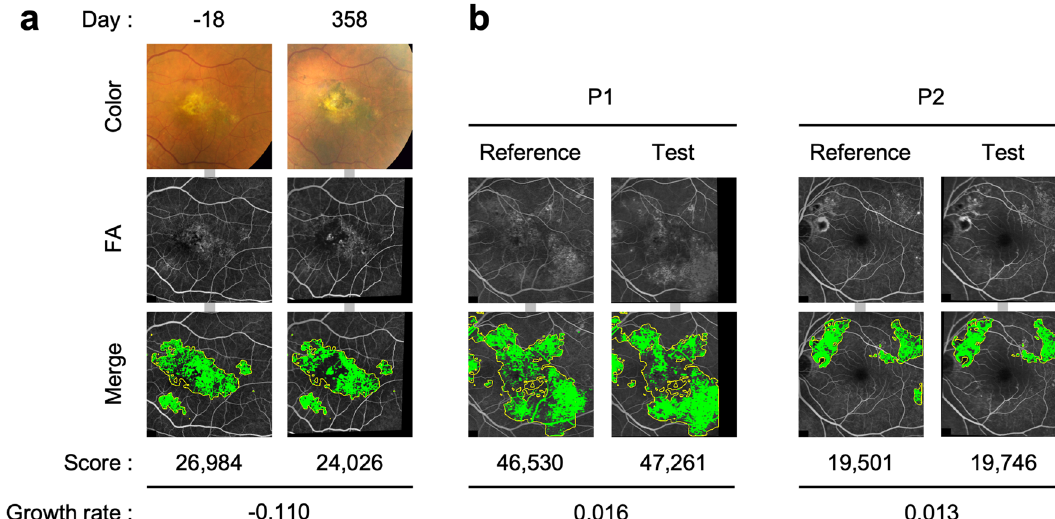
Figure 7. Application of the program to iPSC-RPE cell transplantation and CSC images. ( a ) Quantitative assessment of the Hyperfluorescent areas before and after human iPSC-RPE transplantation in a previously reported case 8 . The date of iPSC-RPE transplantation surgery was defined as day 0. Upper: A pair of fundus color images. The right image shows the black iPS-RPE-transplanted cells at the center of the image. Middle: A pair of FA images aligned, and brightness corrected by image processing. Lower: Binary images. Yellow frames represent Abnormal regions predicted by U-Net. Green areas represent Hyperfluorescent areas. The Score represents the sum of the pixel numbers of the Hyperfluorescent area in the binarized image. The Growth rate represents the (Test score − Reference score)/Reference score. (b) Application of the program to other diseases with Hyperfluorescent areas and central serous chorioretinopathy (CSC). These images were obtained from two different patients (P1-2). Upper: Pairs of FA images aligned and brightness-corrected by image processing. Lower: Output binary images. Yellow frames represent Abnormal regions (Mask area) predicted by U-net. Green areas represent Hyperfluorescent areas. The Score represents the sum of the pixel numbers of the Hyperfluorescent area in the binarized image within the Mask area. The Growth rate represents the (Test score − Reference score)/Reference